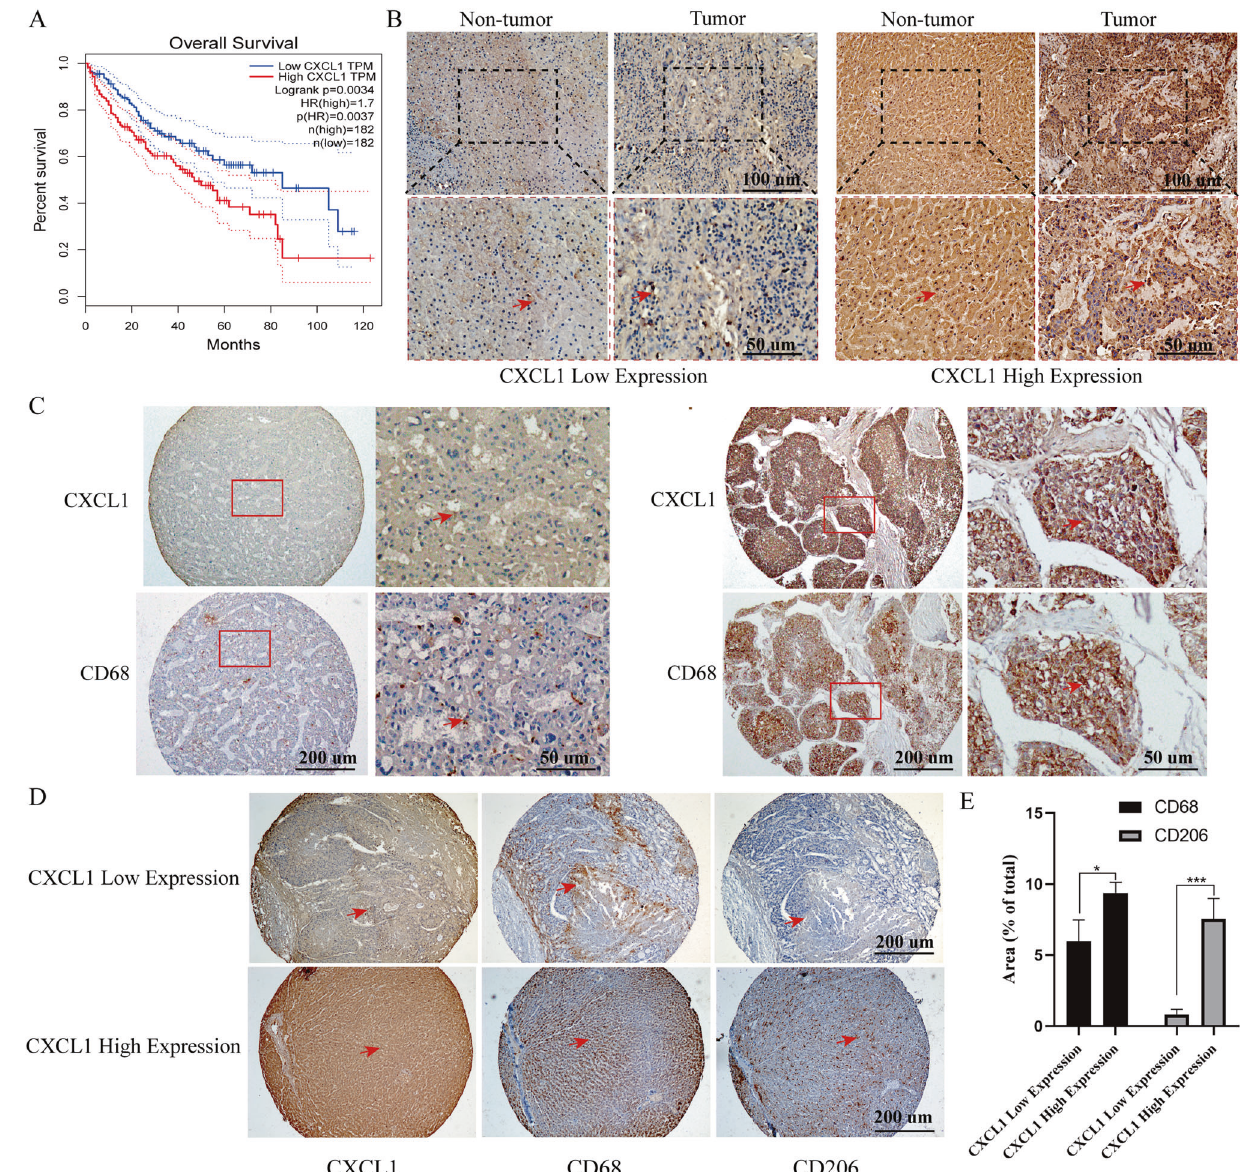
Fig. 1 High CXCL1 expression predicts a poor prognosis in HCC, and is positively related to macrophage enrichment. A Overall survival plot of CXCL1 expression in HCC patients was analysed through the GEPIA database ( n = 364). B The expression of CXCL1 in tumour tissues and adjacent nontumor tissues was measured by IHC. Arrows indicate positive staining. Scale bar, 100 μ m (up) and 50 μ m (down). C – E CD68 and CXCL1 staining and representative images of the same tissue. D CXCL1, CD68, and CD206 staining in the same tissues. Arrows indicate positive staining. Scale bar, 200 μ m. E The relationship between CXCL1 expression and the CD206 + /CD68 + cell ratio. Data are expressed as the mean ± SEM. ** P < 0.01, ns, nonsigni fi cant ( n = RESULTS High CXCL1 expression predicts a poor prognosis in HCC and (Table 1). A positive relationship between cirrhosis and CXCL1 is positively related to macrophage enrichment levels was also found in the analysis paired adjacent tissues CXCL1 expression levels in tumour samples from HCC patients (Table S2). We used immunohistochemistry to further assess the were analysed through the GEPIA database. Patients with high relationship between CXCL1 and macrophages in HCC tissues. CXCL1 expression had a poor prognosis (Fig. 1A). To further Notably, the proportion of CD68-positive cells was positively con fi rm the relationship between prognosis and the pathological related to CXCL1 expression (Fig. 1C). We observed the enrich- characteristics of HCC patients with various expression levels of CXCL1, we performed immunohistochemistry of HCC and paired adjacent nontumorous tissues on paraf fi n-embedded TMAs. The results showed that CXCL1 expression levels were similar between HCC tissues and paired adjacent nontumorous tissues (Fig. 1B). The expression level of CXCL1 was higher in most HCC patient